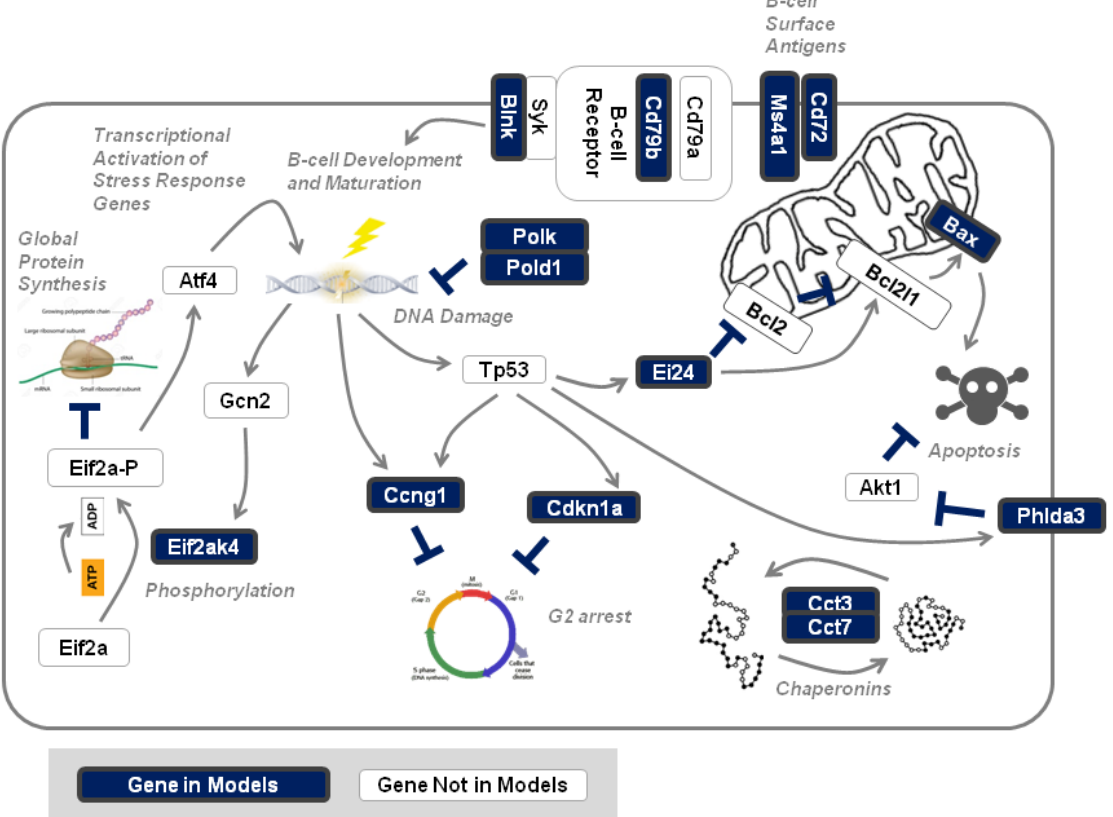
Figure 4. Depiction of the major cellular functions of most frequently appearing genes of the best murine signatures (same genes presented in Figure 1 and Figure